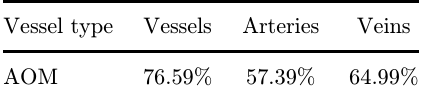
Table 1. AOM of di®erent vessel